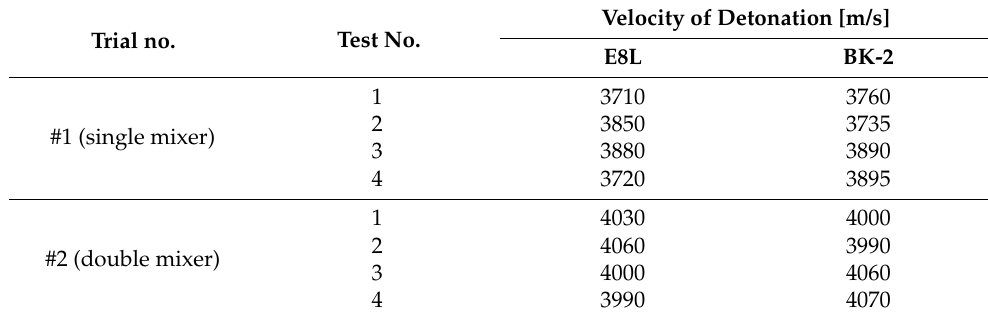
Table 3. Summary of the results of detonation velocity measurements. Trial no. Test